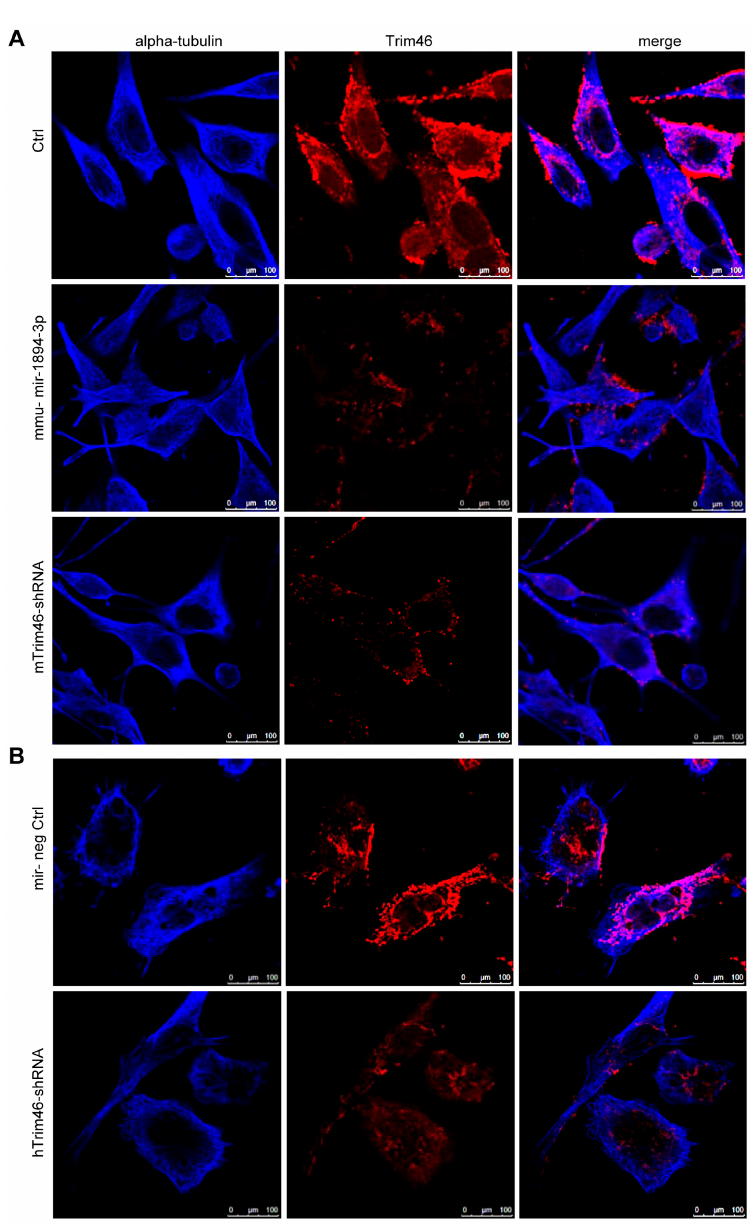
Figure 5. Subcellular localization of Trim46 by immunofluorescence. ( A ) 4TO7 cells expressing miR-neg control or mmu-miR-1894-3p or Trim46-shRNA were stained with α -tubulin (blue) and Trim46 (red) antibodies. Scale bars are 100 μ m; and ( B ) MBA-MD-231 cells expressing miR-neg control and Trim46-shRNA cells were stained with α -tubulin (blue) and Trim46 (red) antibodies. Scale bars are 100 μ m.